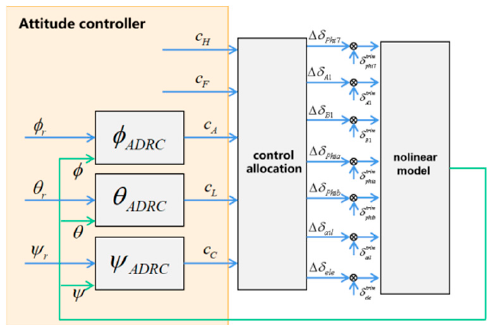
Figure 5. Attitude